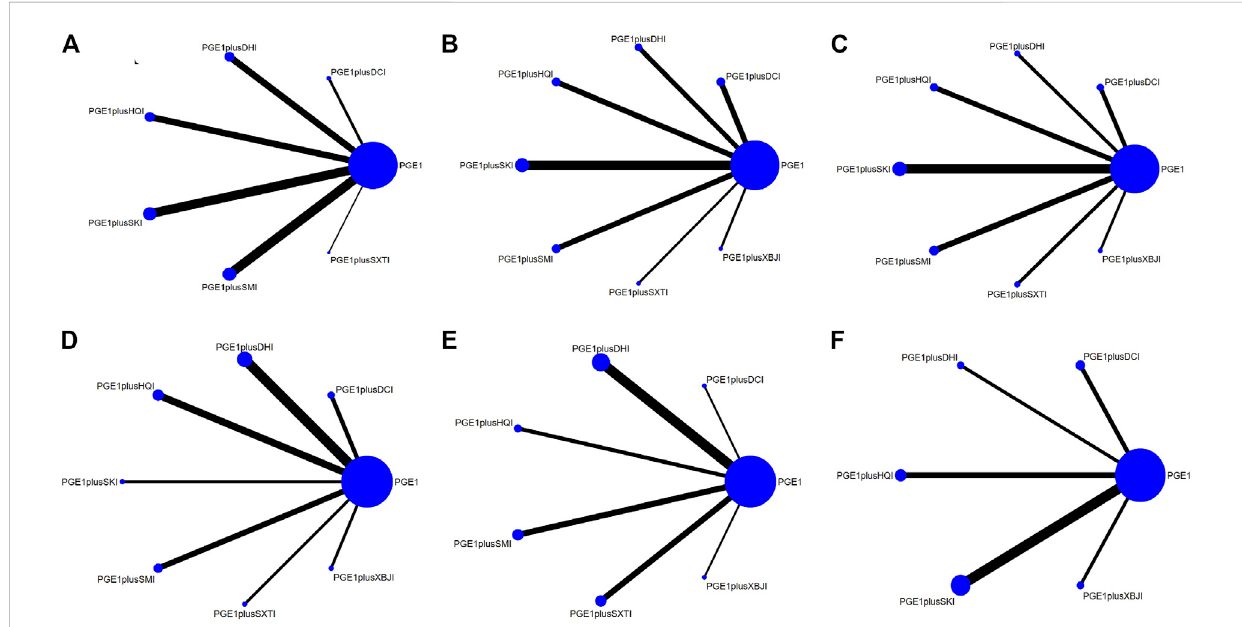
FIGURE 2 Network diagrams for different